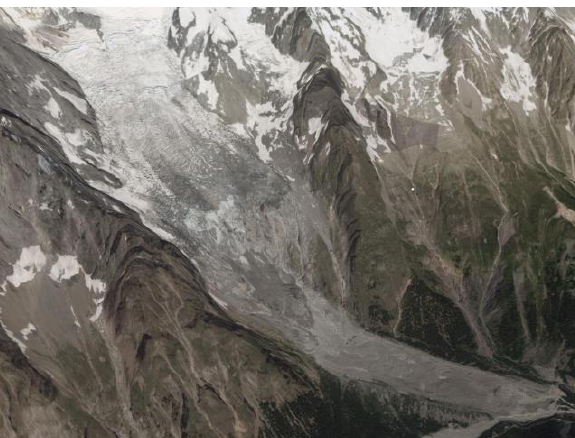
Figure 1. The location of the Brenva glacier, between other glaciers in the area, in the Aosta Valley in Italy.